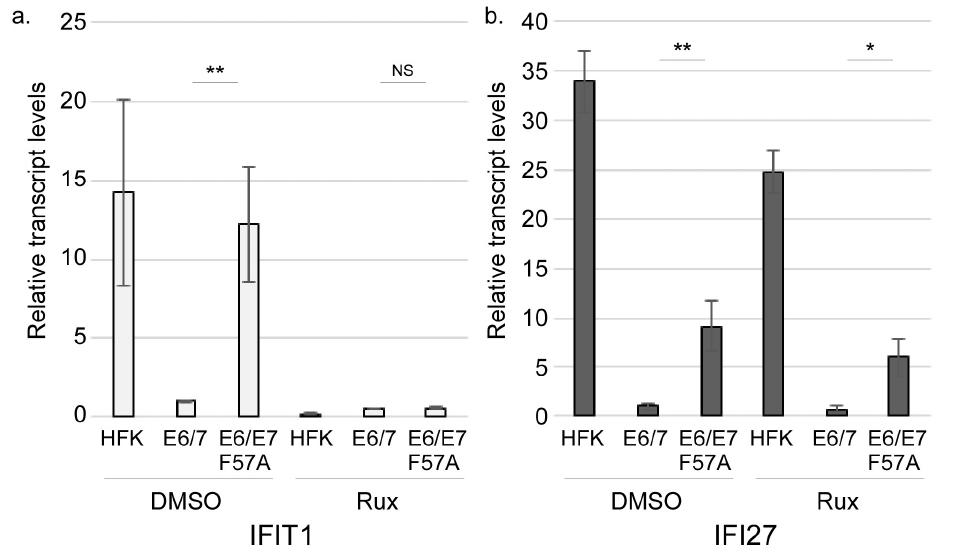
Figure 3. Effect of Ruxolitinib on ISG levels. RT-qPCR analysis of IFIT1 ( a ) or IFI27 ( b ) transcript levels in HFKs, pLXSN E6 / E7, and pLXSN E6 / E7 F57A cells treated with DMSO (control) or 10 µ M Ruxolitinib (Rux) for 24 h under monolayer culture conditions. Transcripts were normalized to cyclophilin A housekeeping gene, with DMSO-treated pLXSN E6 / E7 samples set to 1.